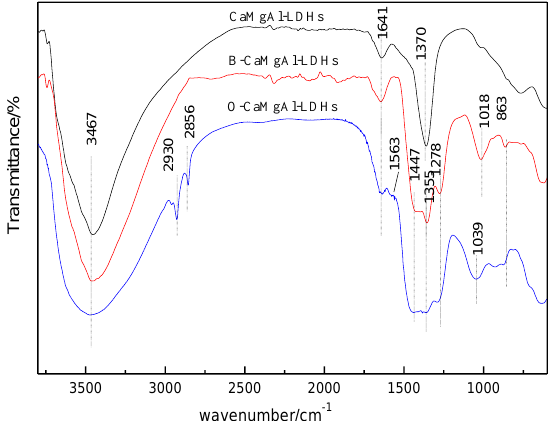
Figure 2. FT-IR patterns of CaMgAl-LDHs, B-CaMgAl-LDHs, and O-CaMgAl-LDHs.